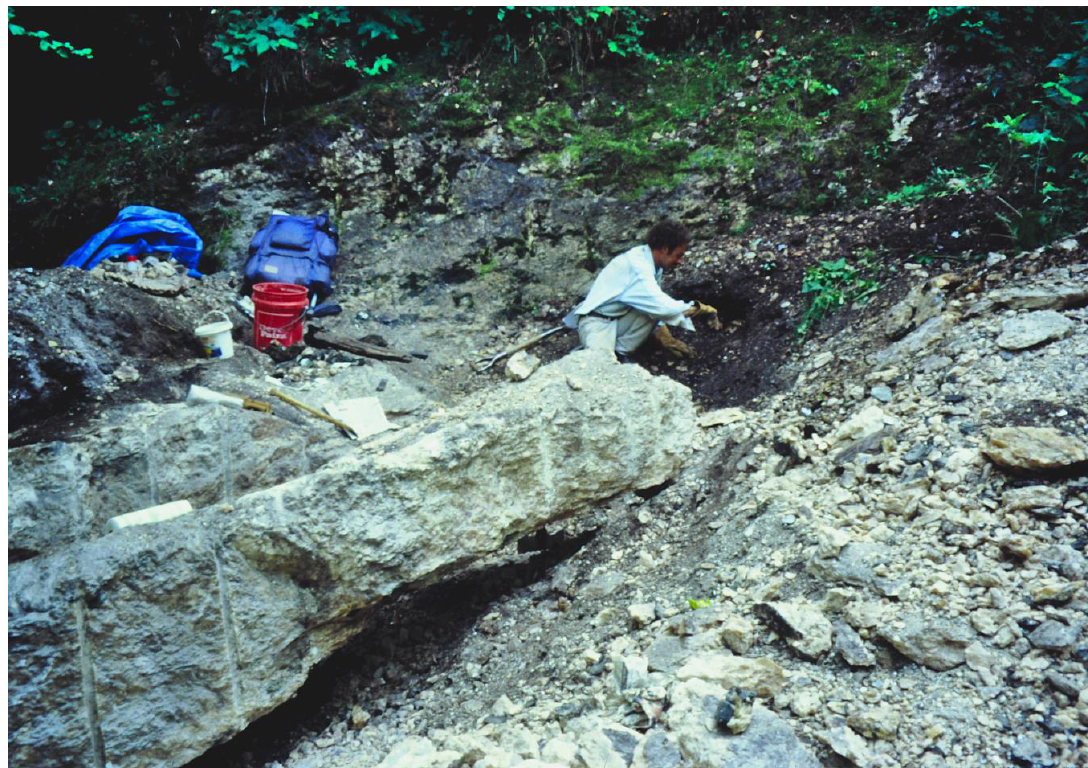
Figure 2. Collector (Jay Medici) excavating the weathered carbonatite for mineral specimens in a portion of the deposit especially rich in betafite. Betafite and apatite are primarily hosted in the calcite core of the carbonatite, while silicate minerals are more abundant at the coarsely mineralized margins where the carbonatite contacts silicate country rock.